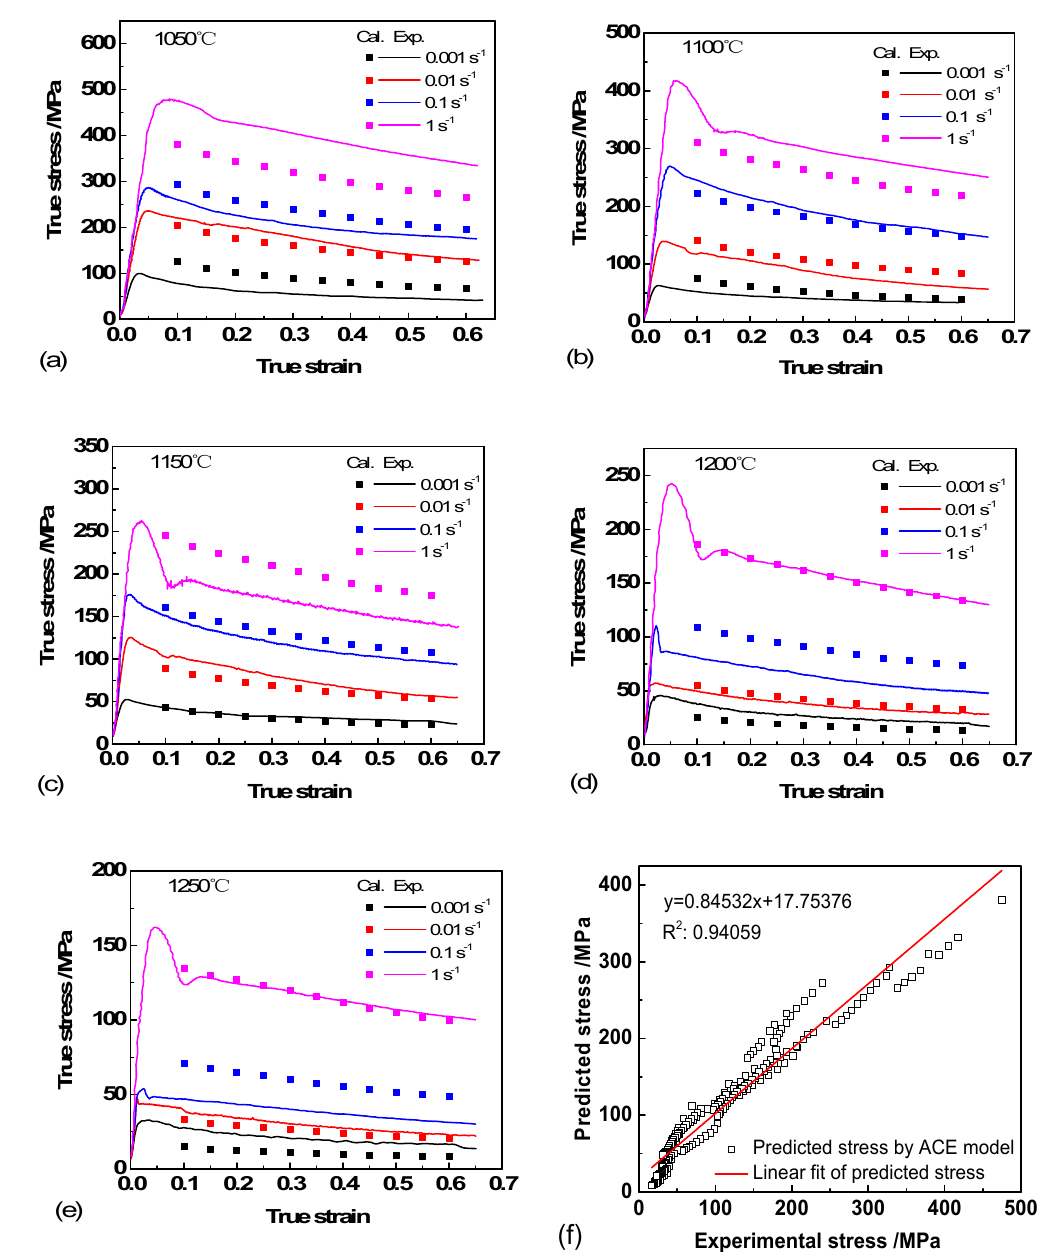
Figure 3. Comparison of stress–strain curves between tests and Arrhenius constitutive model at different temperatures and strain rates: ( a ) 1050 °C; ( b ) 1100 °C; ( c ) 1150 °C; ( d ) 1200 °C; ( e ) 1250 °C; ( f ) correlation analysis.